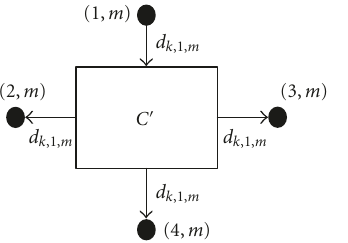
Figure 7: Intracell conferencing channel in the m th cell with J = 4 users per cell. In the illustrated example, during the k th conferencing round, the (1, m )th MS is communicating message d k ,1, m to the other same-cell MSs